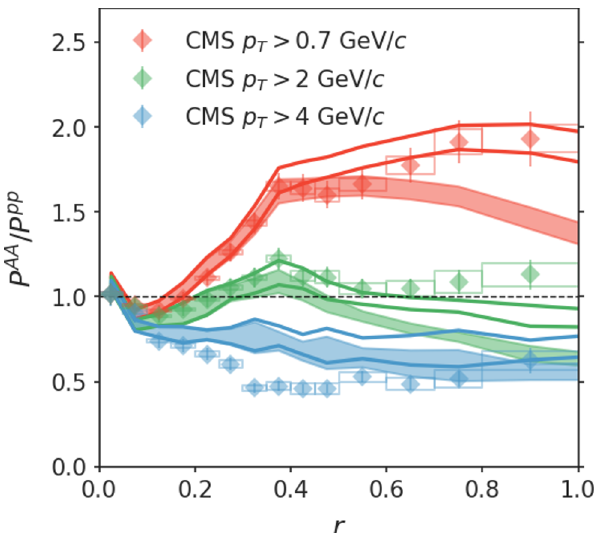
Figure 16 . Prediction of the p T -cut dependent jet shape compared to data from the CMS mea- surement [109]. The lines and symbols from top to bottom corresponds to the jet shape constructed using particles with p 0 . 7 , 2 . 0 , and 4.0 GeV/ c respectively. Filled color bands are direct model T > predictions and open color bands are predictions corrected by the ad hoc